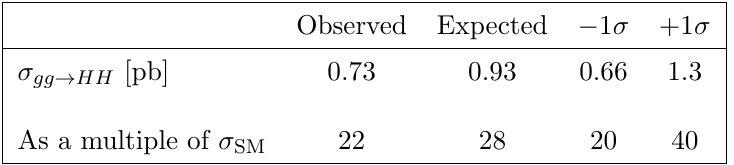
Table 4. The 95% CL observed and expected limits on the Higgs boson pair cross-section in pb and as a multiple of the SM production cross-section. The (cid:6) 1 (cid:27) band around each 95% CL limit is also indicated.